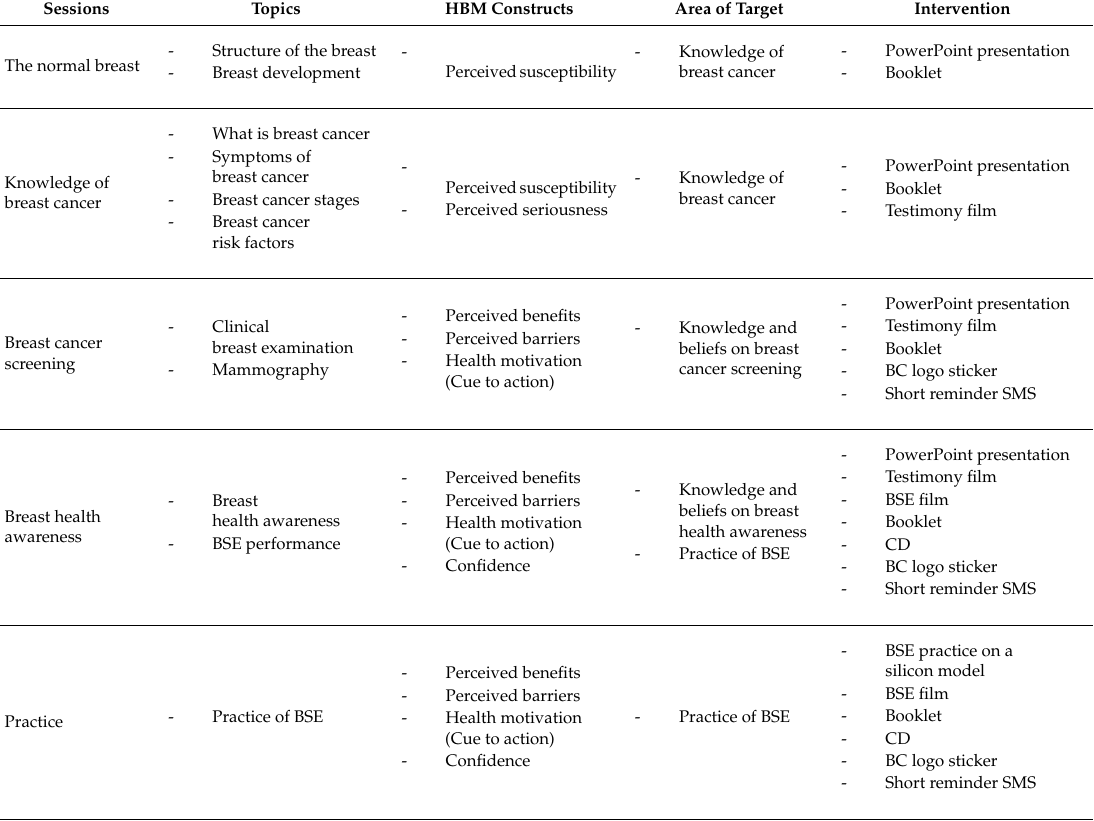
Table 1. Outline of the educational intervention on breast cancer